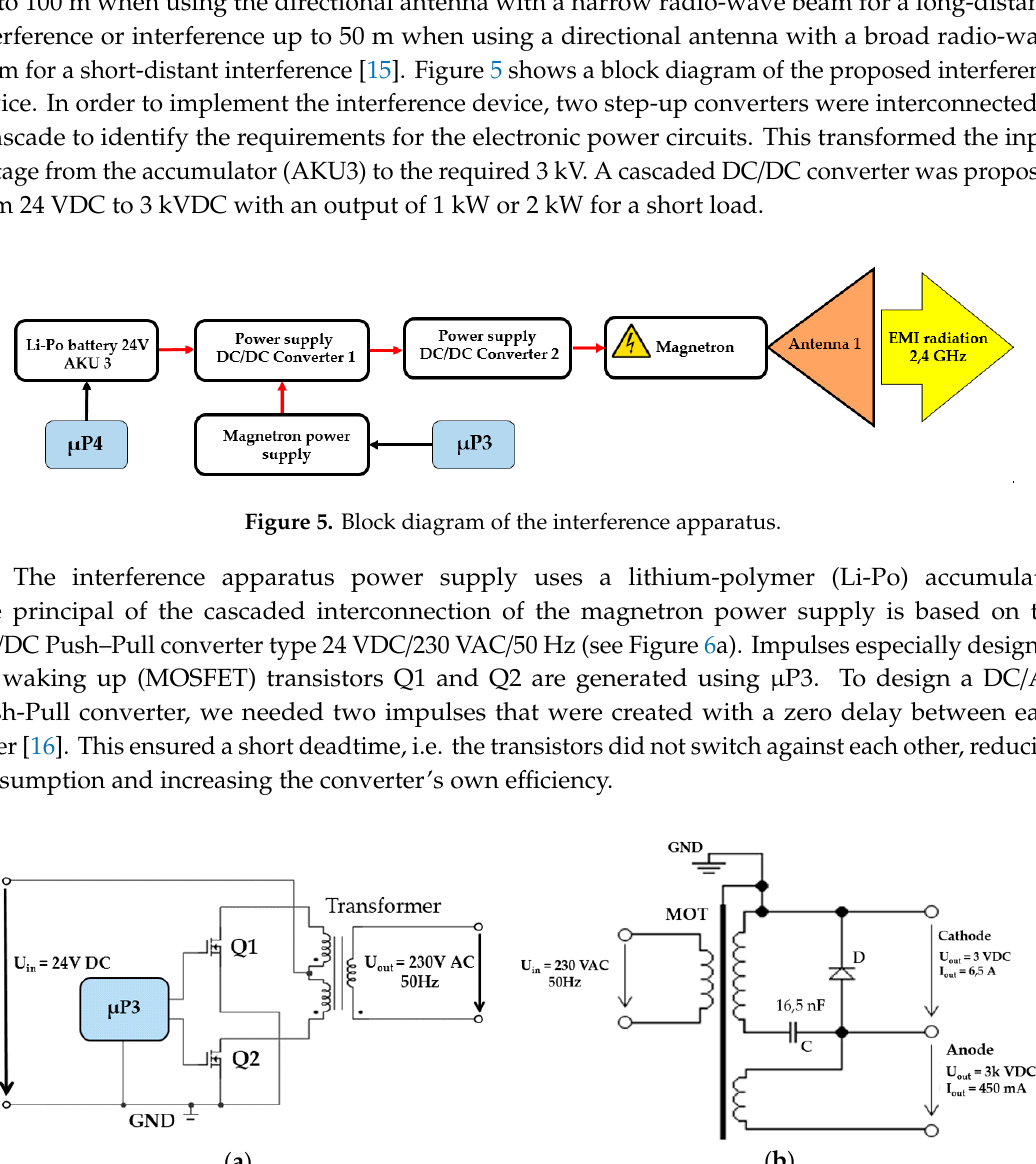
Figure 4. Displaying the monitoring equipment for the accumulators’ capacity.